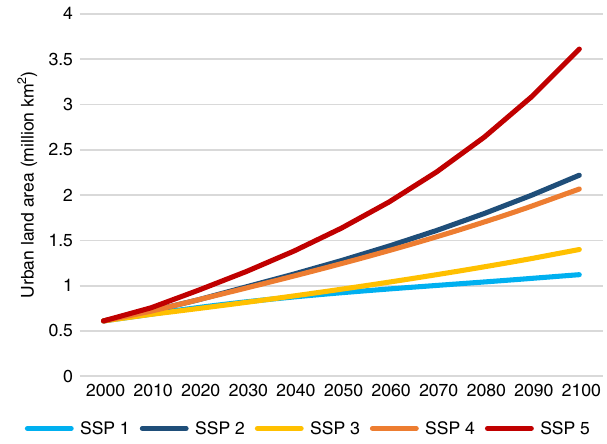
Fig. 1 Global total amount of urban land under different scenarios over the 21st century. The scenarios correspond to the fi ve Shared Socioeconomic Pathways (SSPs 1 – 5): sustainability, middle of the road, regional rivalry, inequality, and